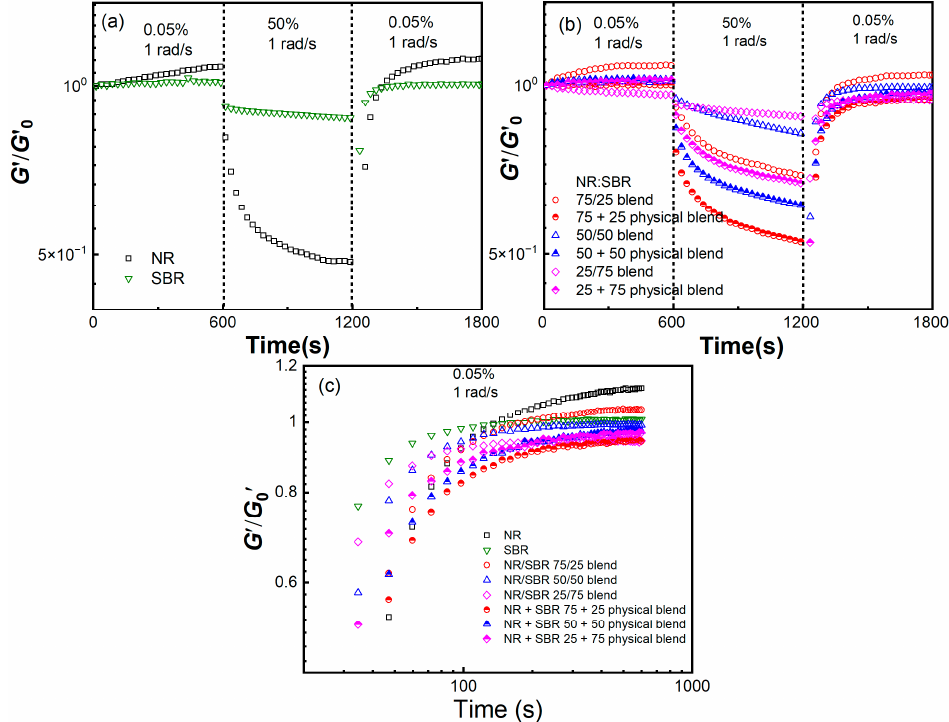
Figure 8. G ′ /G ′ 0 as a function of lasting time for ( a ) pure NR and SBR, ( b ) NR/SBR blends and NR + SBR physical blends being sheared stepwise to γ = 0.05%, 50% and 0.05 at ω = 1 rad/s. ( c ) is extracted from ( a , b ) for clearly showing the normalized modulus recovery process for NR, SBR, NR/SBR blends and NR + SBR physical blends at ω = 1 rad/s from large to small strain steps ( γ = 50% shear to γ = 0.05%).